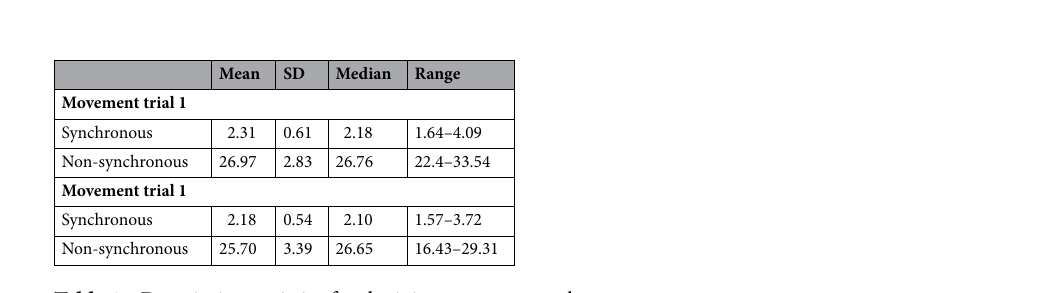
Table 1. Descriptive statistics for the joint movement